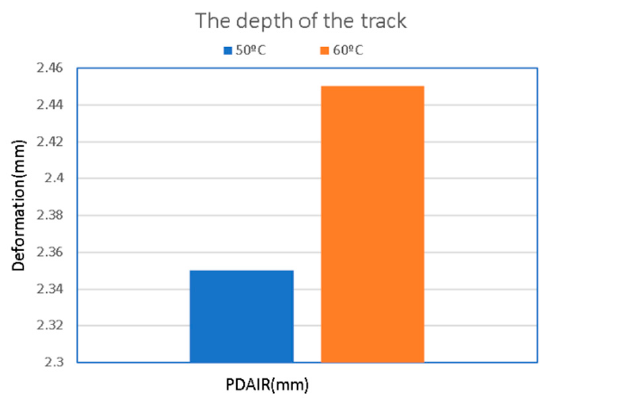
Figure 9. ( a ) K-type sensor position ( b ) graphic comparison between measured and simulated data.